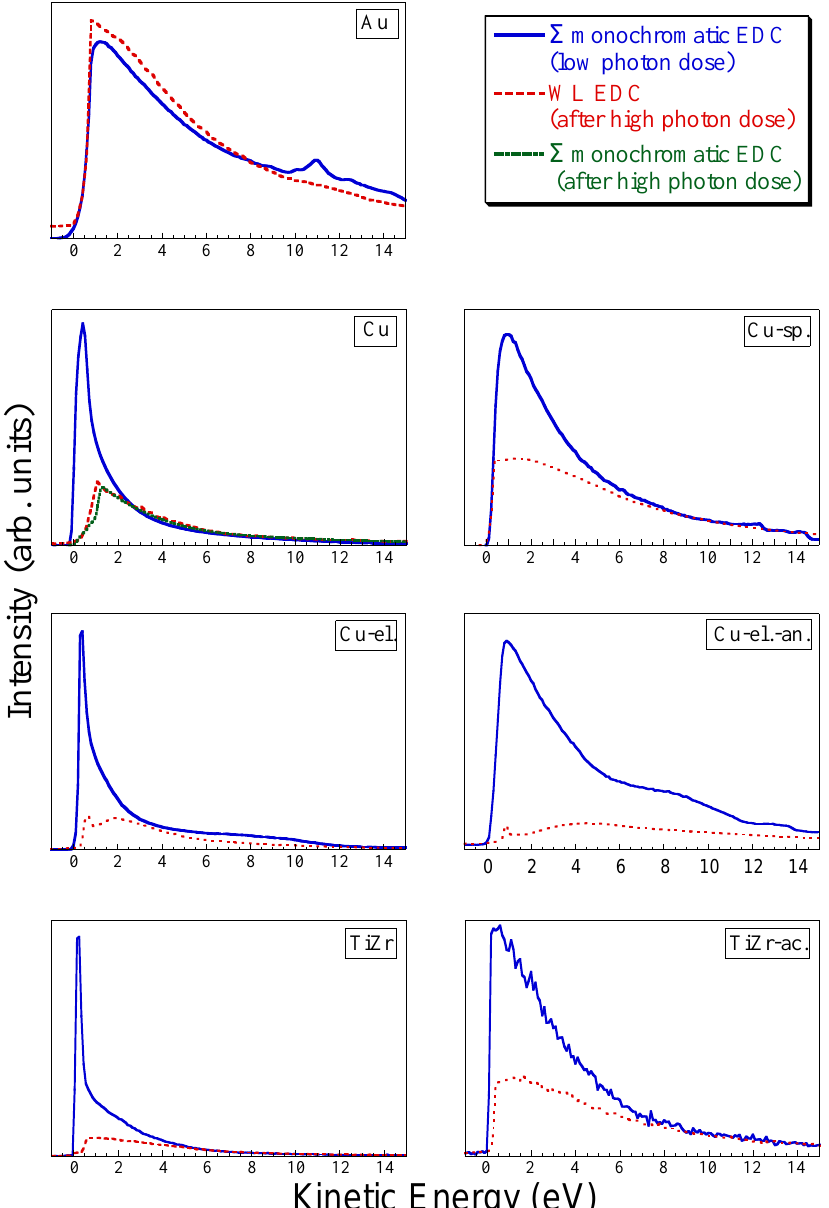
FIG. 17. (Color) Selected low photon dose spectra generated from a summation of the monochromated EDCs (blue solid line) compared with their corresponding WL EDC (red dashed line). The sum of the monochromatic EDCs (after high photon dose) is only shown for Cu (green xxx